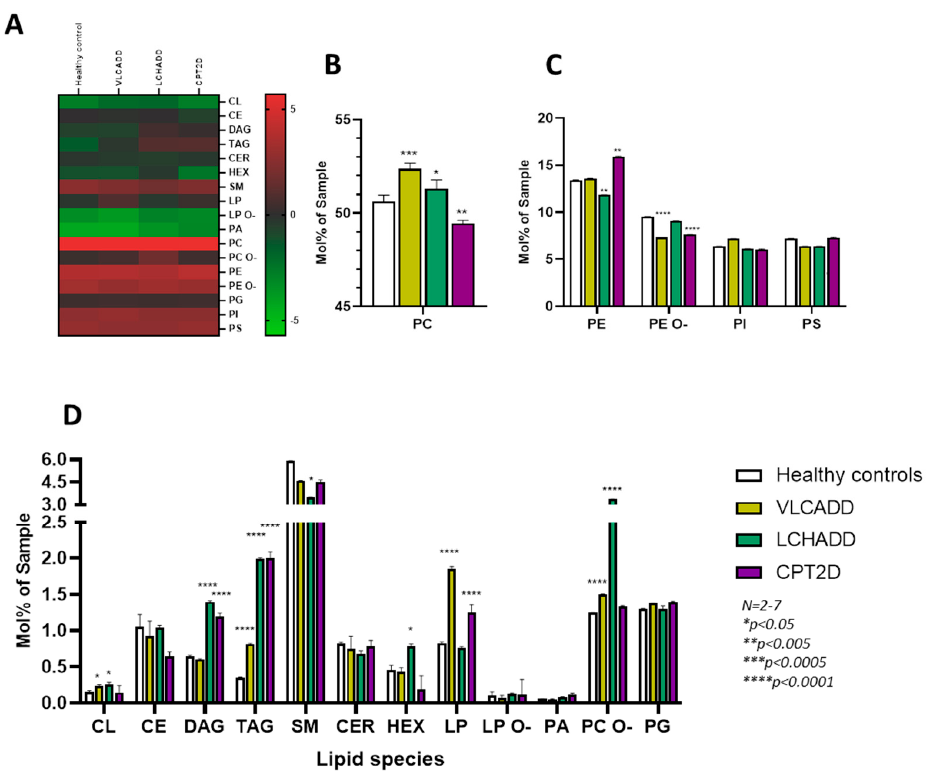
Figure 1. Disease specific alteration of lipid composition. ( A ) Heatmap of log2 transformed lipids concentration from fibroblasts of healthy controls and from VLCADD, LCHADD and CPT2 patients under control conditions (2 fold enrich- ment, p -value < 0.05). ( B – D ). Quantification of different lipid classes in fibroblasts from of healthy controls and from VLCADD, LCHADD and CPT2 patients under control conditions. Mol % sample: indicates the moles of the lipid species extracted from one sample calculated as percentage of the total amount of lipid extract. PC: Phosphatidylcholine; PE: Phosphatidylethanolamine; PE O-: Phosphatidylethanolamine (-ether); PI: Phosphatidylinositol; PS: Phosphatidylserine; SM: Sphingomyelins; CL: Cardiolipins; CE: Cholesterol Ester; DAG: Diacylglycerides; TAG: Triacylglycerides; CER: Ce- ramides; HEX: Hexosylceramides; LP: Lysophospholipids; LP O-: Lysophospholipids (-ether); PA: Phosphatidic acid; PC O-: Phosphatidylcholine (-ether); PG: Phosphatidylglycerol. Values denoted by * were considered significant if p < 0.05 (Two way ANOVA; Mann–Whitney test; Friedman test and Tukey’s Test). * indicates significant differences between healthy controls and